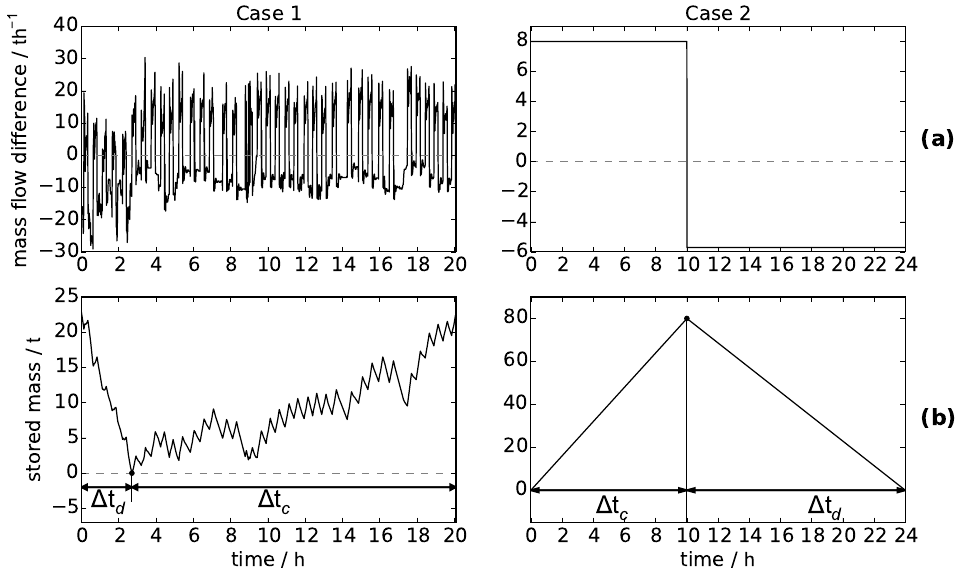
Figure 4. ( a ) Difference between charging and discharging steam mass flow as function of time. ( b ) Stored steam mass as function of